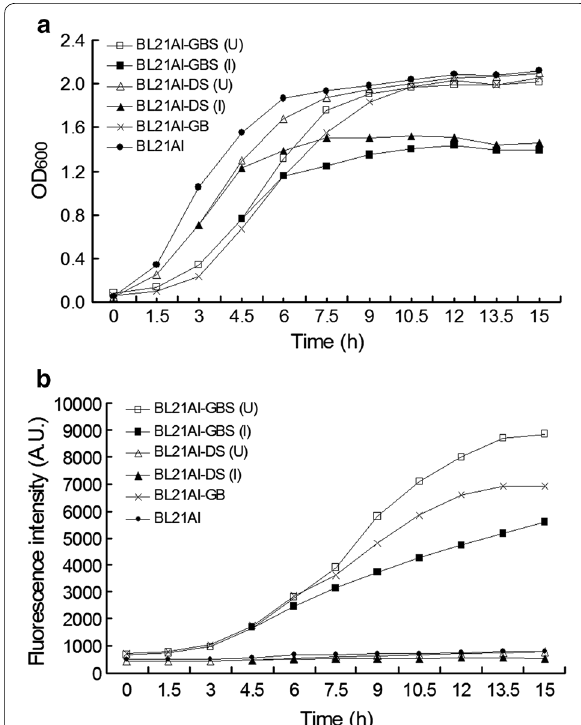
Fig. 2 Growth curves ( a ) and fluorescence intensity ( b ) of BL21AI‑GBS, BL21AI‑DS, BL21AI‑GB, and E. coli BL21AI TM . Cultures of BL21AI‑GBS and BL21AI‑DS were divided into two parts when their optical density (OD 600 ) was in the range of 0.500–0.800. One part was induced by adding 0.01% arabinose, while the other used as a non‑induced control. The optical density and intensity of fluorescence of all cultures were detected every 1.5 h with a spectrophotometer and a fluorescence spectrophotometer, respectively. U and I indicate the uninduced culture and induced culture, respectively